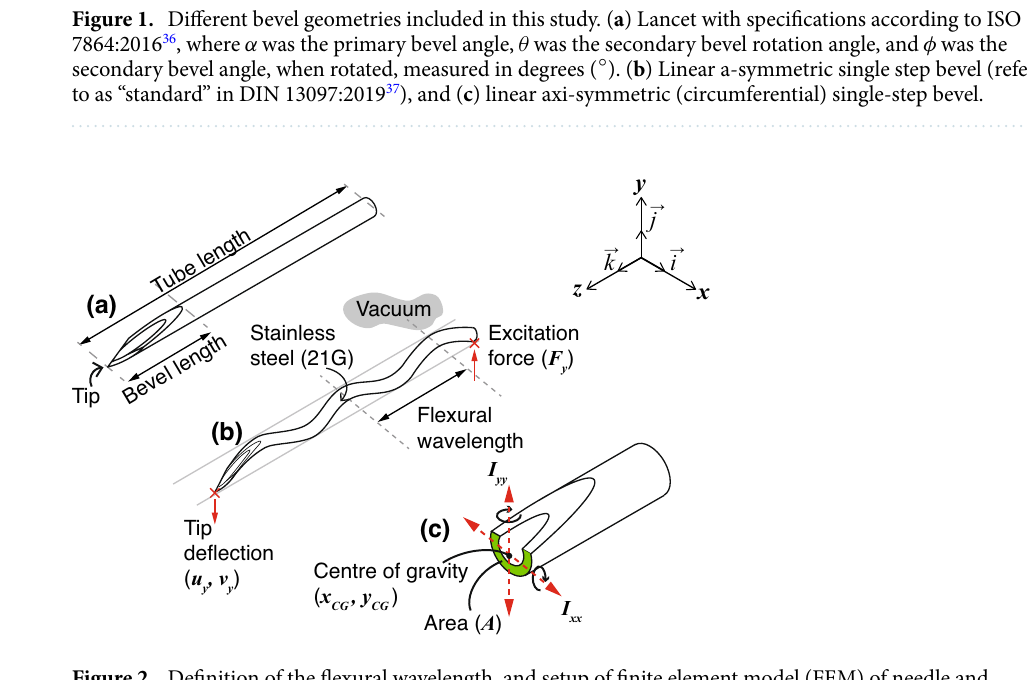
Figure 2. Definition of the flexural wavelength, and setup of finite element model (FEM) of needle and boundary conditions. ( a ) Definition of the bevel length (BL) and tube length (TL). ( b ) A 3-dimensional (3D) finite element model (FEM) employed a harmonic point force ˜ F y � j to excite the needle tube at the proximal end, u y j , v y j ) was measured at the tip to allow a calculation of transfer mechanical a point deflection and velocity ( � � ˜ ˜ mobility. (cid:31) y was defined as the flexural wavelength associated with the vertical force ˜ F y � j . ( c ) Definitions of the centre of gravity, the cross-sectional area A , and the moments of inertia I xx and I yy , around the x and y axes,